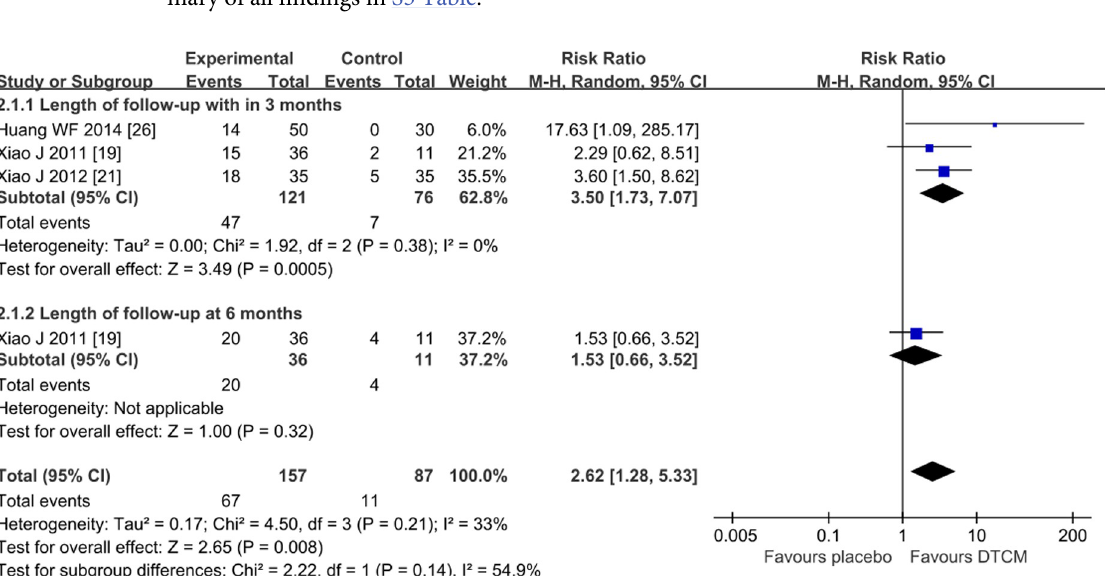
PLOS ONE | https://doi.org/10.1371/journal.pone.0213062 March 1,